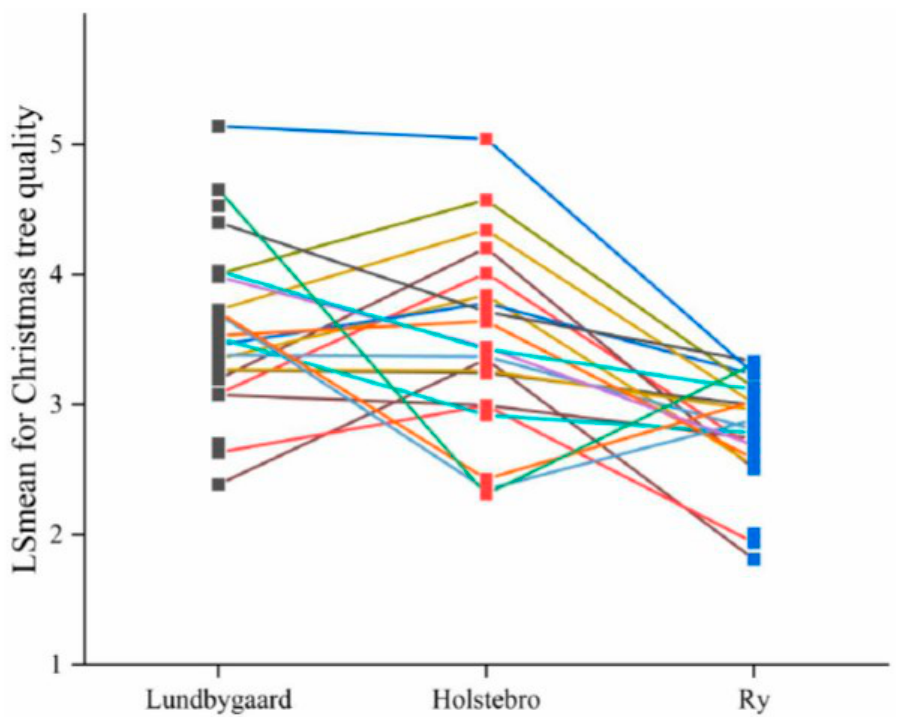
Figure 8. LSmean of Christmas tree quality score for families at different sites. Each line indicates one family.